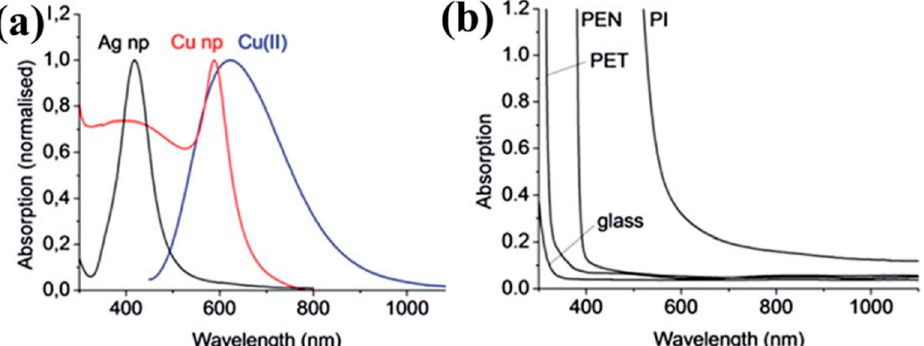
Figure 5. ( a ) UV-Vis absorption spectra of commonly used metallic NPs dispersion of conductive inks and ( b ) substrates for printed electronic applications. Reproduced with permission from [77]; Copyright 2014 Royal Society of